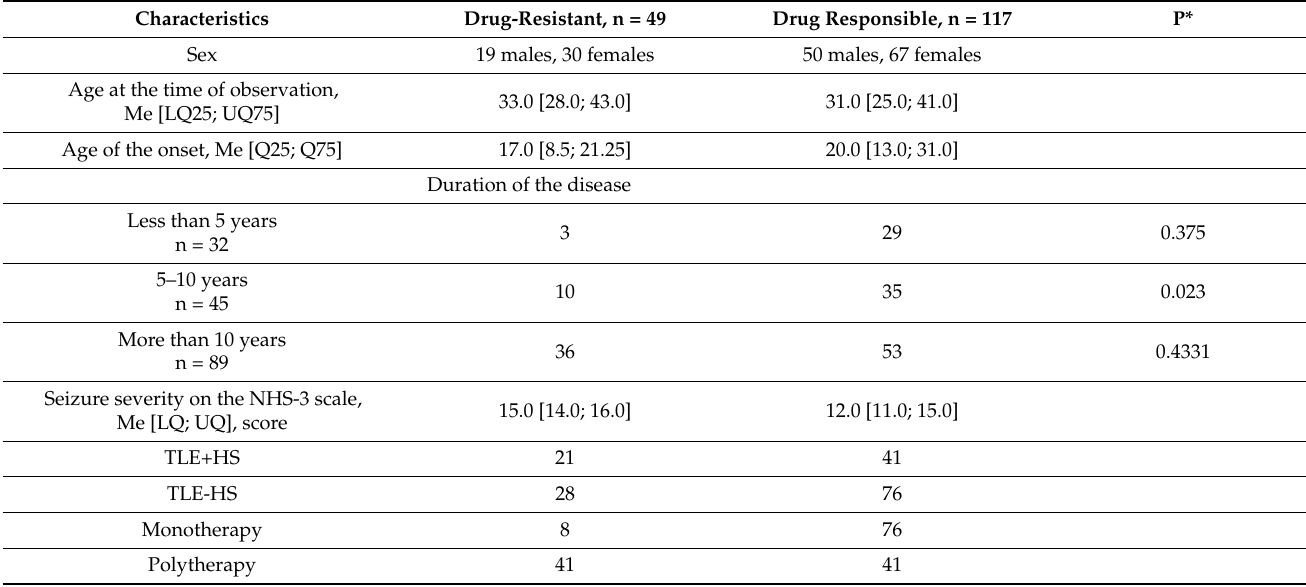
Table 1. Clinical characteristics of the